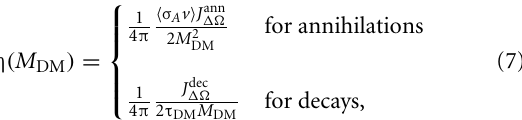
FIGURE 2 | Annihilation cross section (cid:2) σ A v (cid:3) compatible with DM relic abundance vs. DM mass. The line shown in black corresponds to the simplest case of unsuppressed annihilation. The case of where annihilations at freeze–out are inhibited (see text)